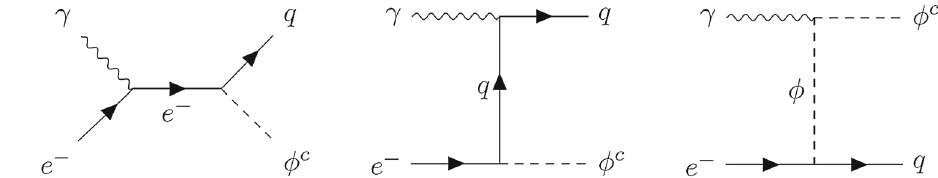
Fig. 1 Feynman diagrams for e − γ → q φ